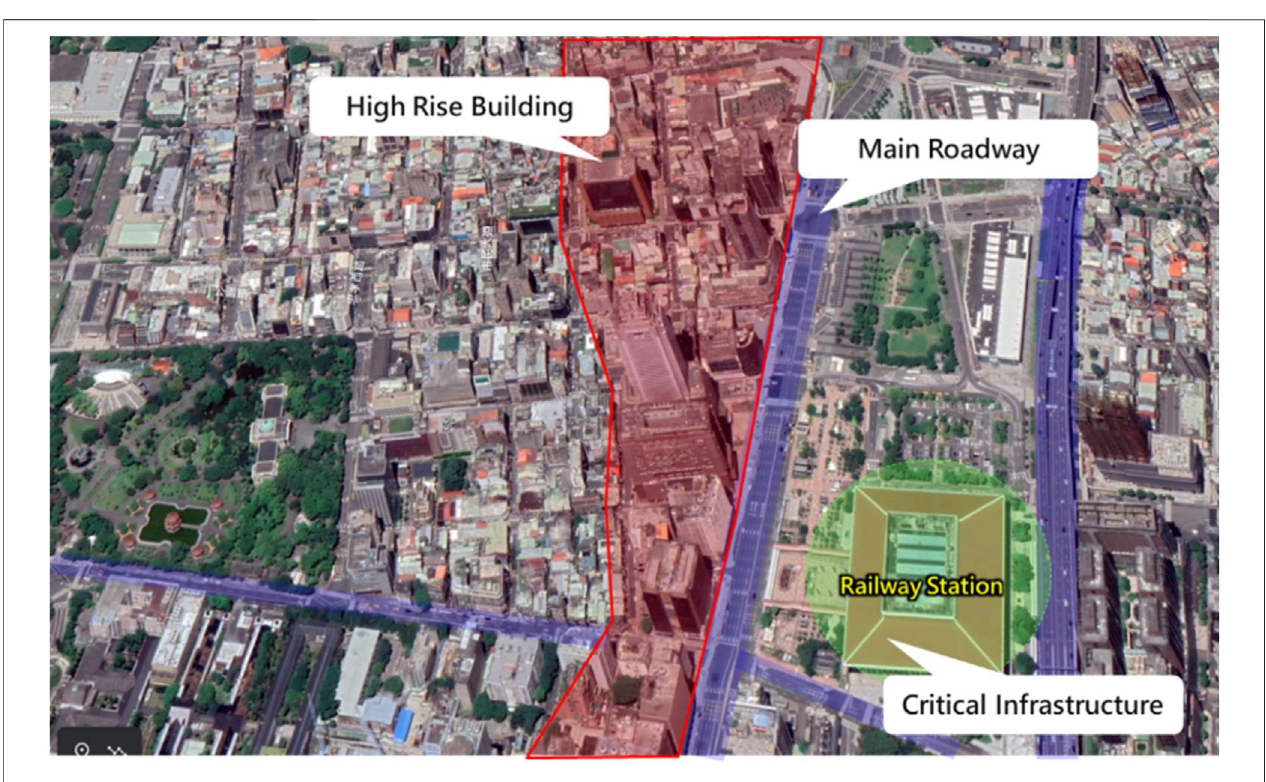
FIGURE 19 | High-rise buildings surrounding Taipei Main